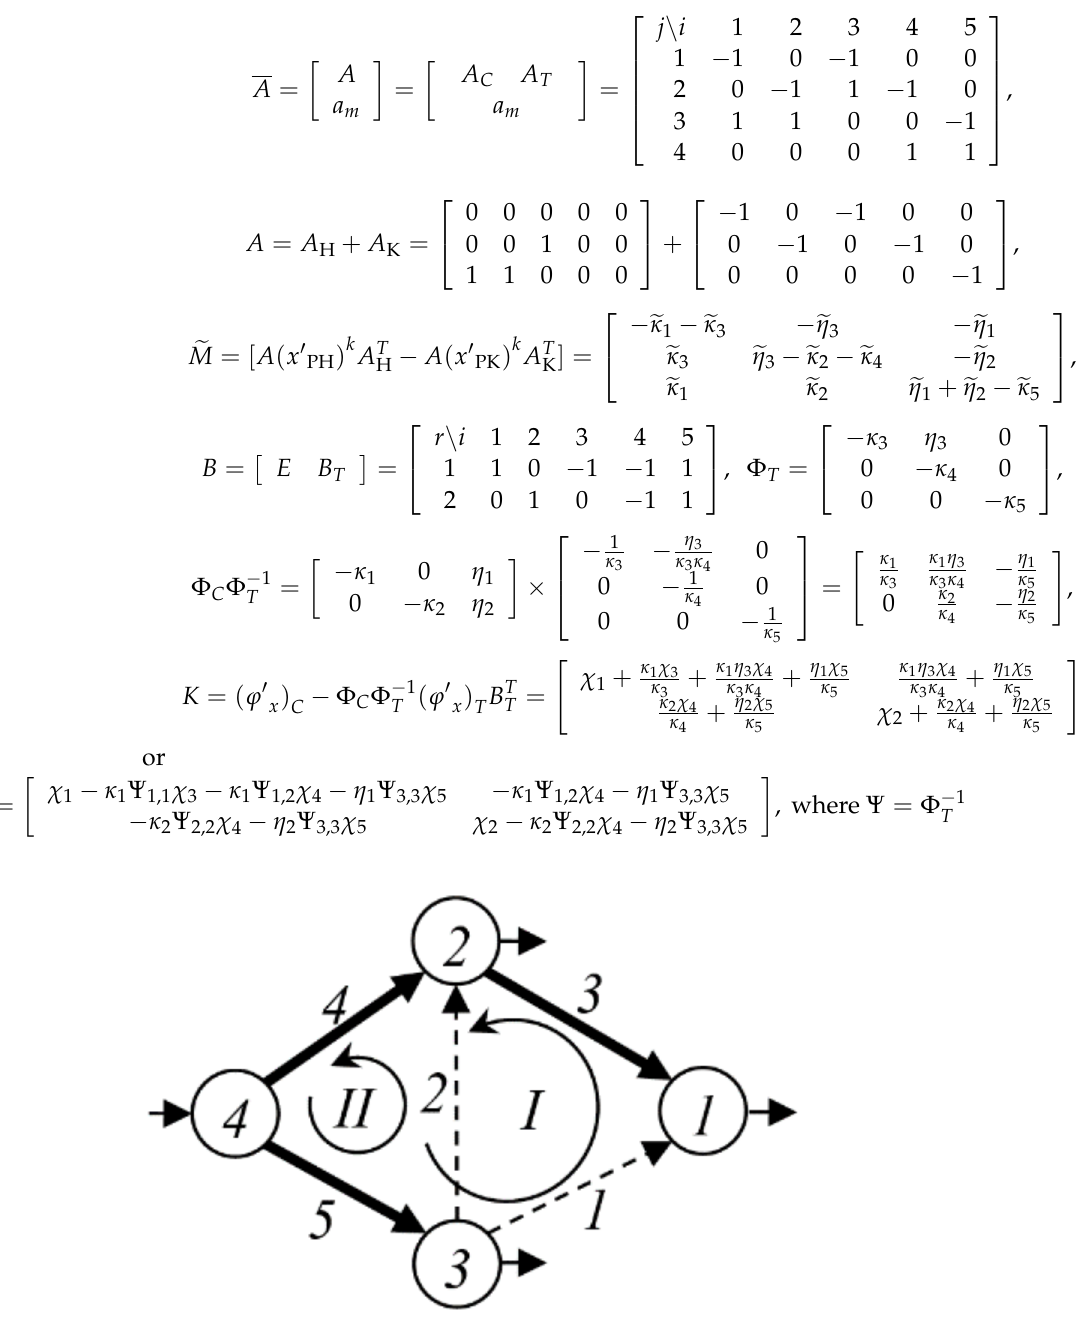
Figure 3. A scheme. Thick lines are spanning tree branches, and dashed arrows are